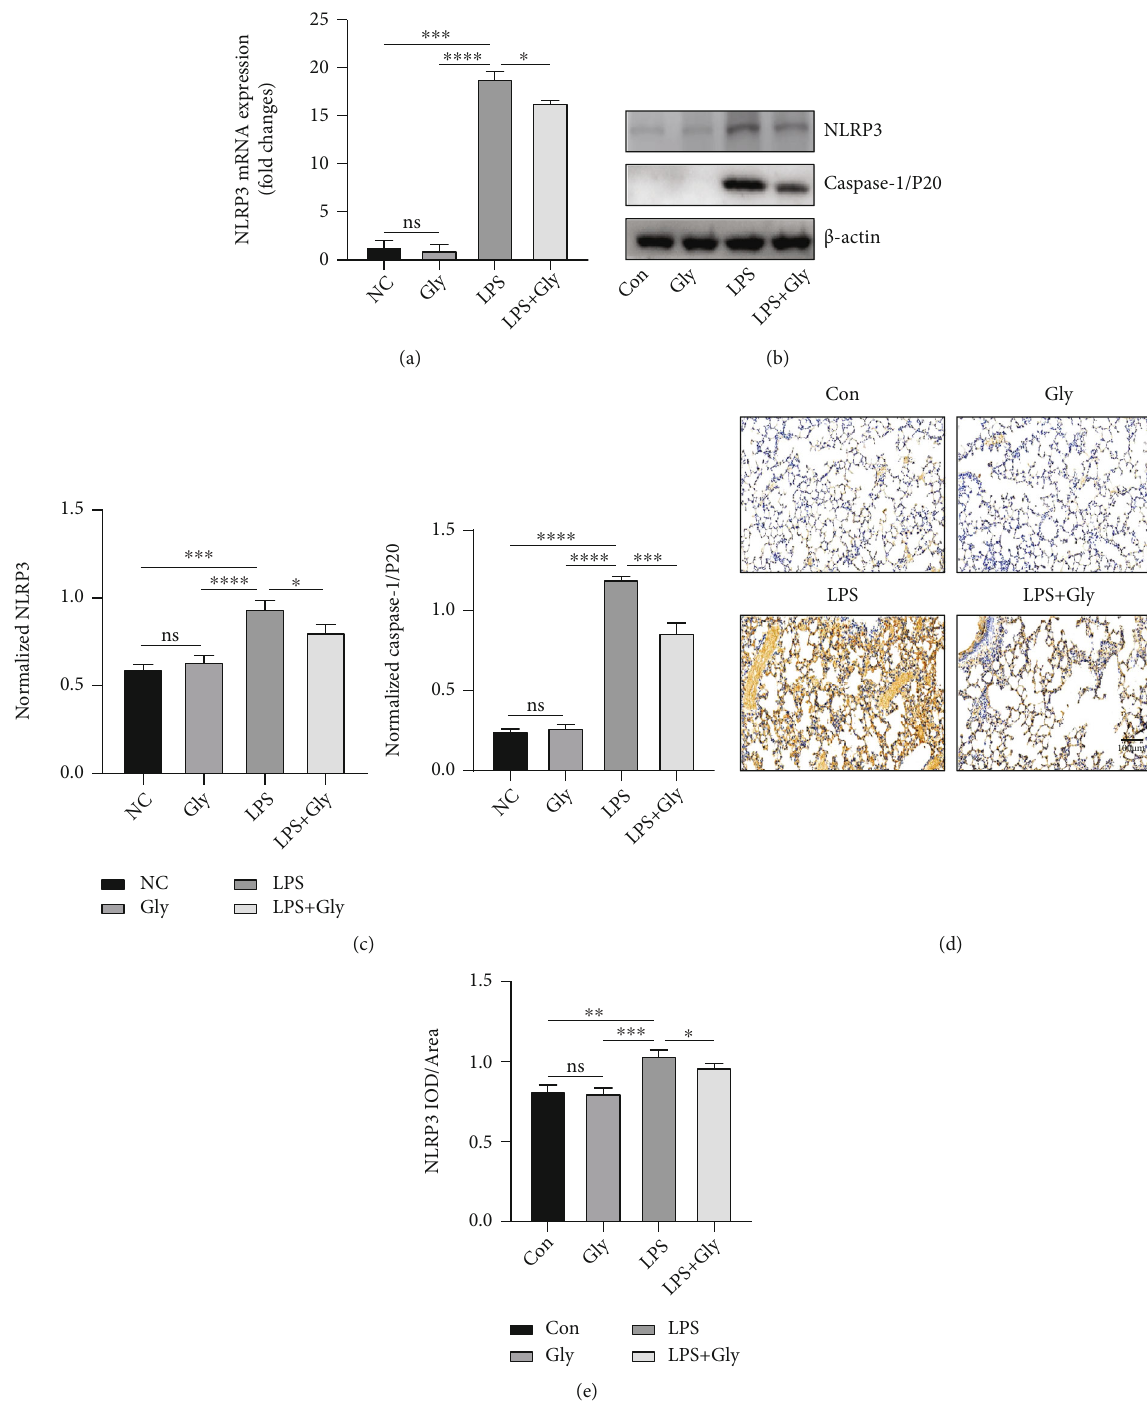
Figure 3: The inhibition role of glibenclamide in the NLRP3/Caspase-1/IL-1 β signaling pathway induced by LPS. (a) Relative NLRP3 mRNA expression in lungs was measured by real-time PCR ( n = 3 ). (b, c) Representative images of Western blot of NLRP3 and Caspase- 1/p20 in the lungs and quantitative analysis ( n = 3 ). (d, e) Representative images of immunohistochemical staining of NLRP3 in the lungs and quantitative analysis ( n = 3 ). Scale bars, 100 μ m. Data are representative of three independent experiments (mean and SD). ns: not signi fi cant. ∗ P < 0 : 05 , ∗∗ P < 0 : 01 , ∗∗∗ P < 0 : 001 , and ∗∗∗∗ P < 0 : 0001 (unpaired Student ’ s t